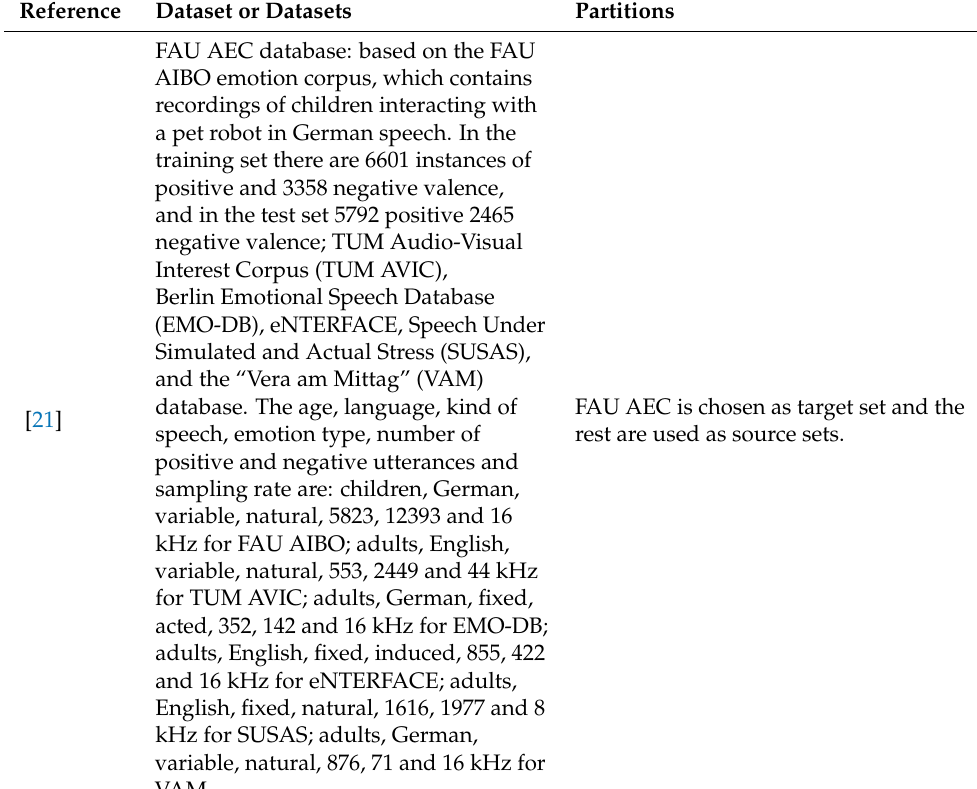
Table 4. Datasets used and partitions for training and testing of the detection approaches